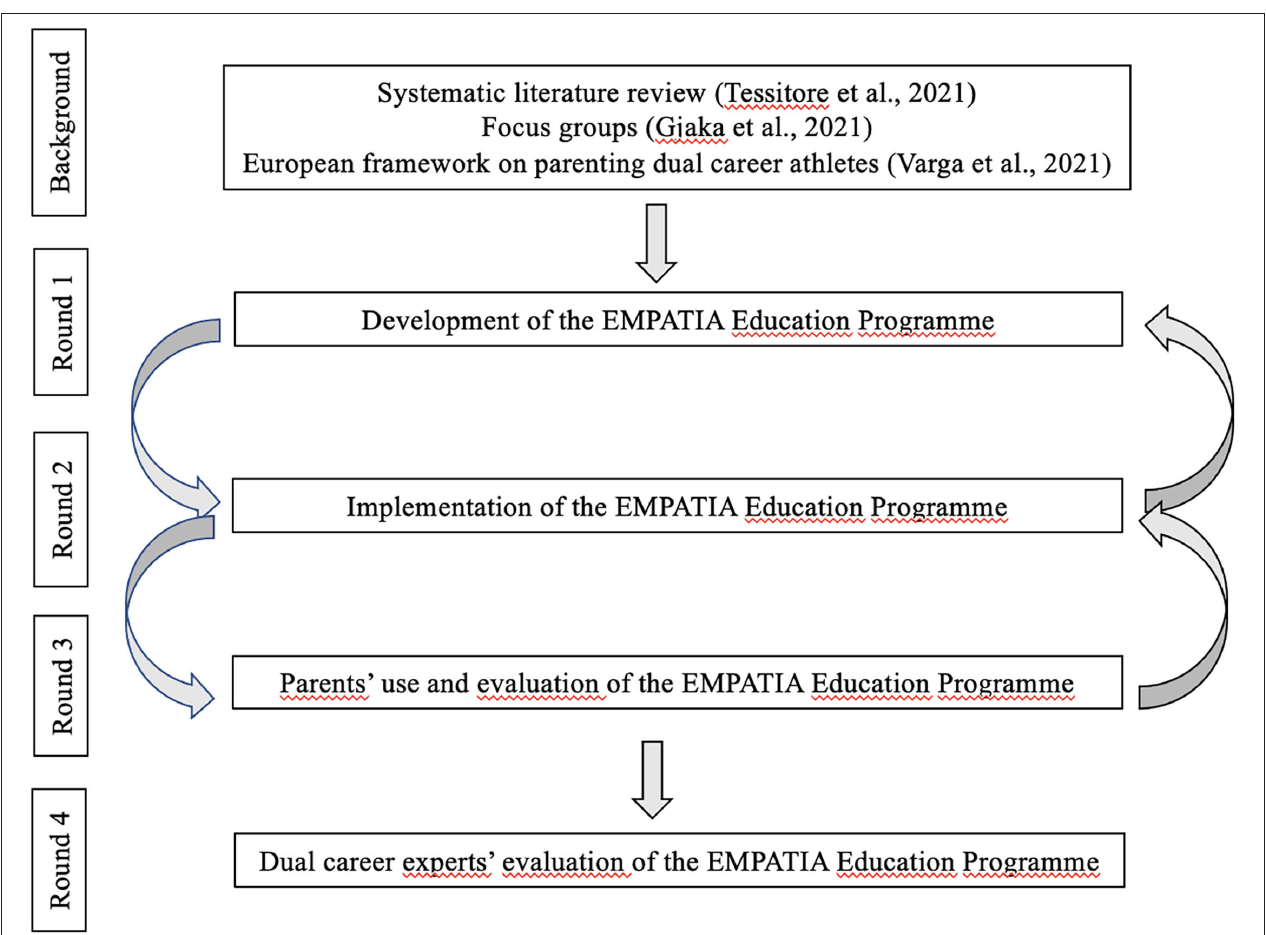
FIGURE 1 | Schematic representation of the four rounds of the development of an online multilingual EMPATIA education programme for parents of dual-career athletes, illustrating the constant back-and-forth circulation of opinions, suggestions, and feedback, between the experts and the end users (i.e., the athletes’